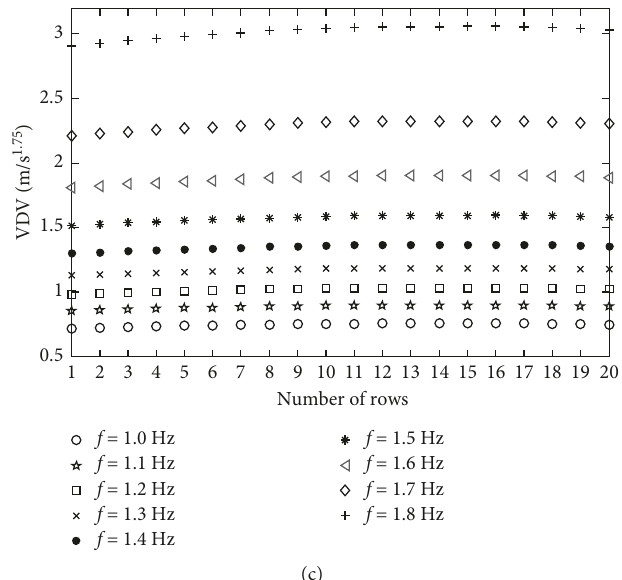
Figure 22: The structural responses when human assumed as mass-stiffness-damping system. (a) Structural nephogram, (b) mises stress and displacement, and (c) the VDVs plotted against the number of